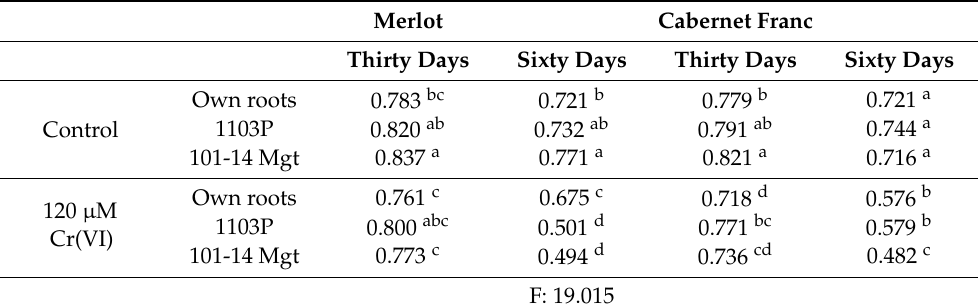
Table 4. Effects of Cr(VI) toxicity on maximum quantum yield of photosystem II (Fv/Fm) of Merlot (M) and Cabernet Franc (CF) grapevine cultivars on their own roots (OR) and on 1103P and 101-14 Mgt rootstocks. Merlot Cabernet Franc Thirty Days Sixty Days Thirty Days Sixty Days Own roots 0.783 bc 0.721 b 1103P Control Own roots Cr(VI) F: